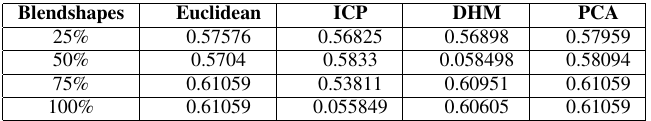
were included in the dataset, the error dropped. This can also be viewed in Figure 11. TABLE I R ESULTS IN MILLIMETERS OF THE PROCESSING OF RANDOMLY GENERATED SETS OF BLENDSHAPES